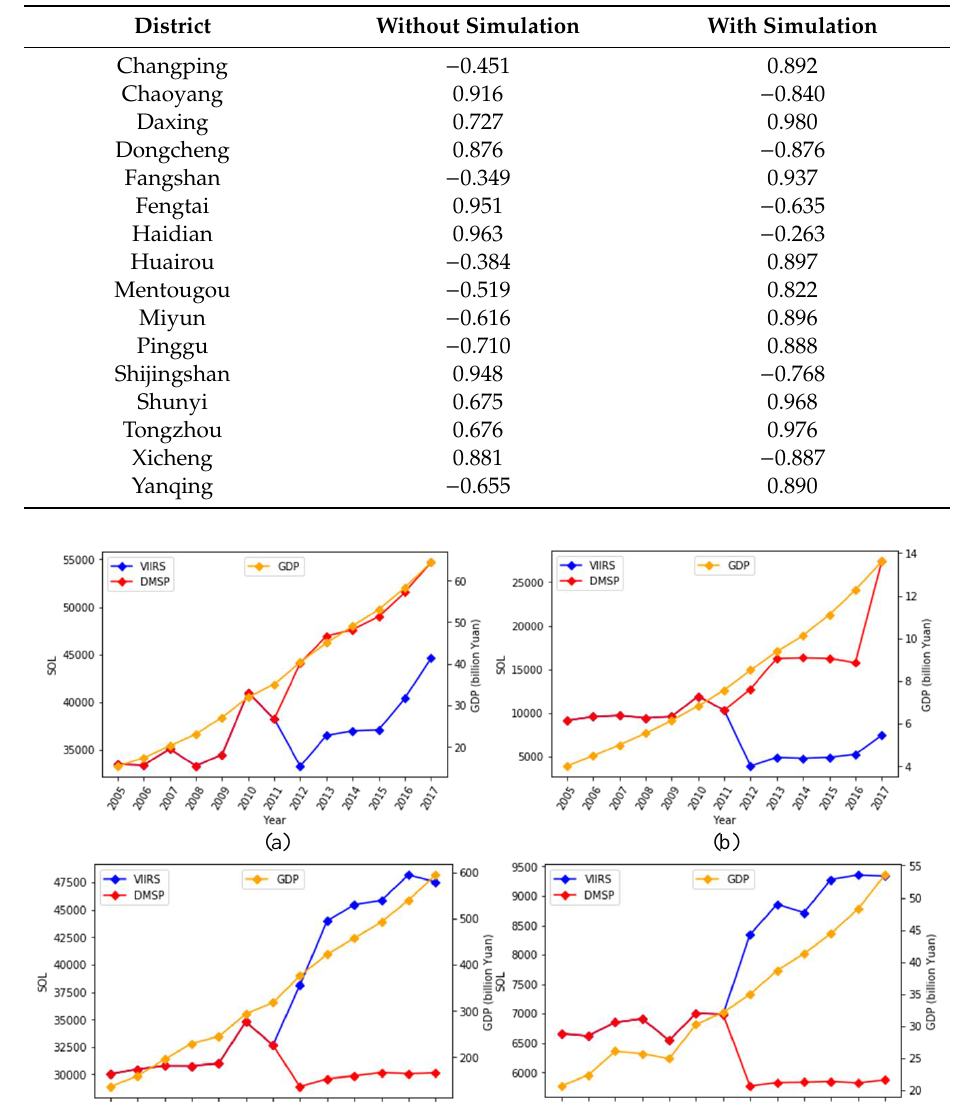
Table 4. Correlation between SOL and GDP of districts in Beijing in 2005–2017.